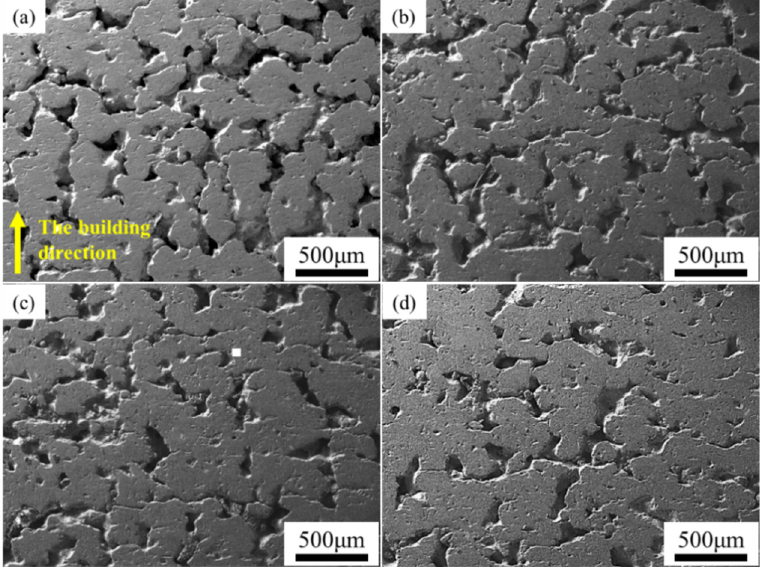
Figure 8. SEM images of the cross-sections of the samples. The scanning speed was 150 mm/s; the laser power values were ( a ) 35 W, ( b ) 40 W, ( c ) 45 W, ( d ) 50 W.